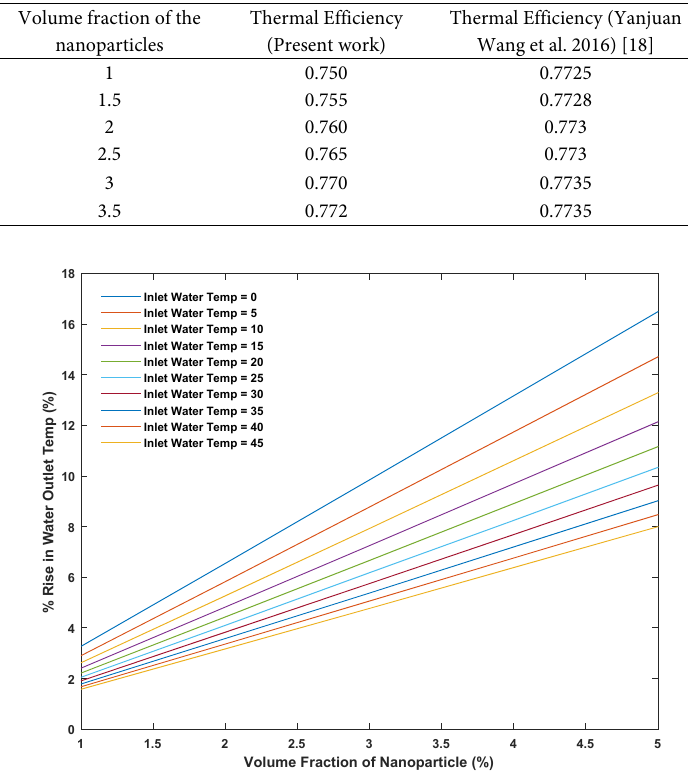
Fig. 5. Effect of volume fraction of the nanoparticle on receiver water outlet